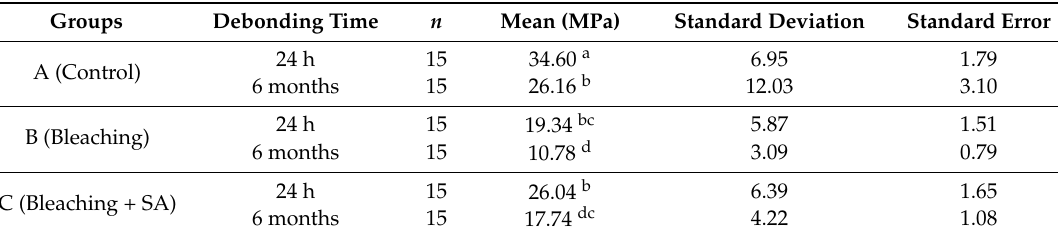
Table 1. The microtensile bond strength values of the test